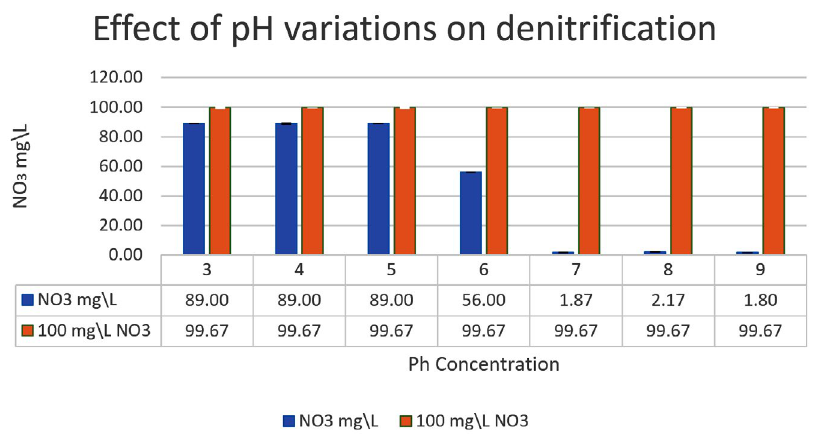
Fig. 6. The effect of pH variations on the denitrification process is shown in the graph. At least 100mg/L nitrate was used as a fixed starting point. It was shown that pH7, 8, and 9 were optimum for denitrification processes by Pseudomonas aeruginosa on glucose